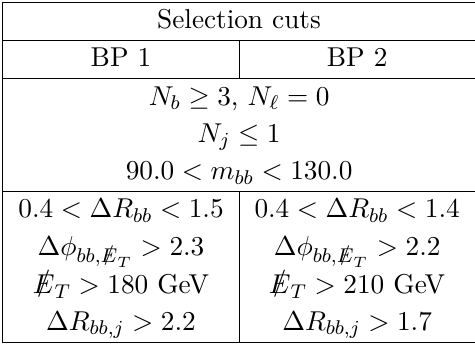
channel for the cut-based analysis. T